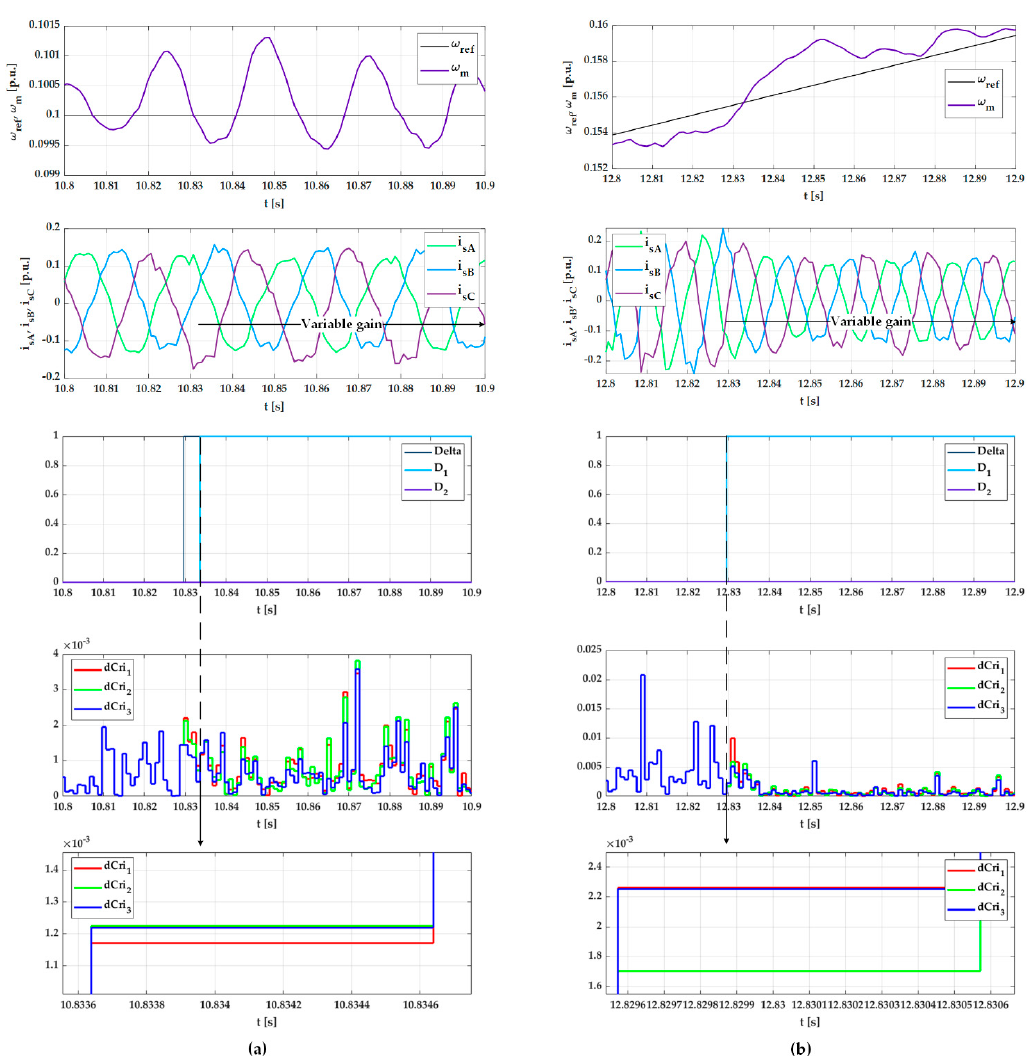
Figure 9. Transients of speed, stator currents, detector responses, and marker errors during variable gain ( γ = 0.2) in phase A for different speed values in stable ( a ) and dynamic ( b ) states.